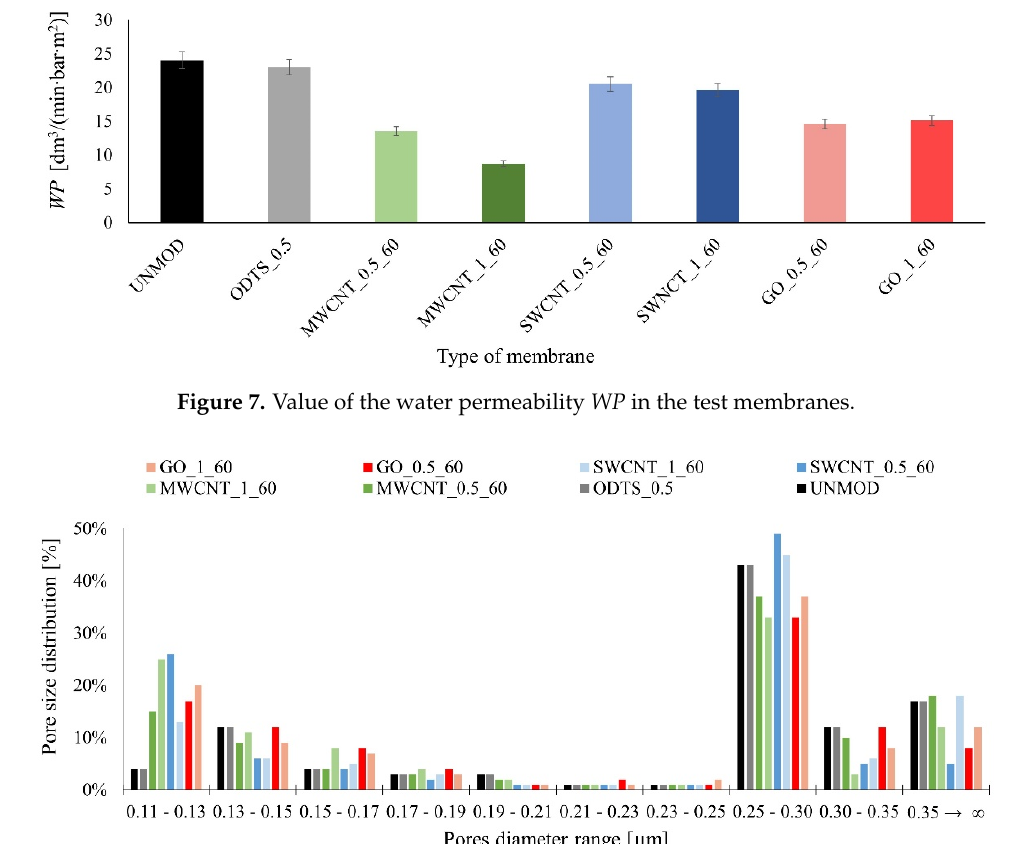
Figure 7. Value of the water permeability WP in the test membranes.